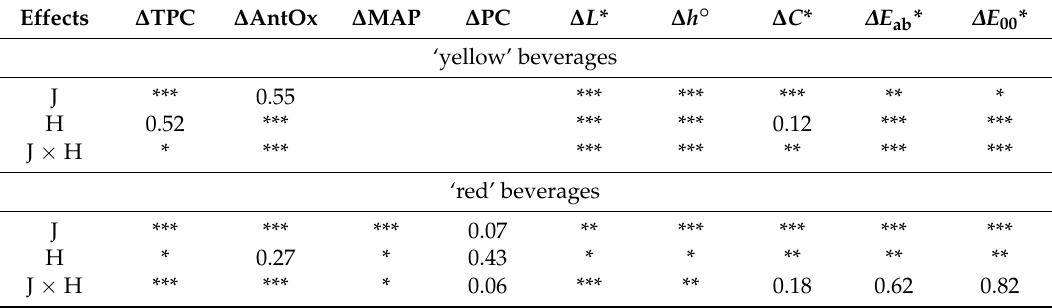
Table 2. Significative influence (* p < 0.05; ** p < 0.01; *** p < 0.001) of the main factors juice used in the preparation of the RCW-based beverages (J), heat treatment (H) and their interaction on changes in antioxidants and color parameters occurring with pasteurization of ‘yellow’ and ‘red’ fruit-RCW beverages. Non-significant differences are given as exact p -value.